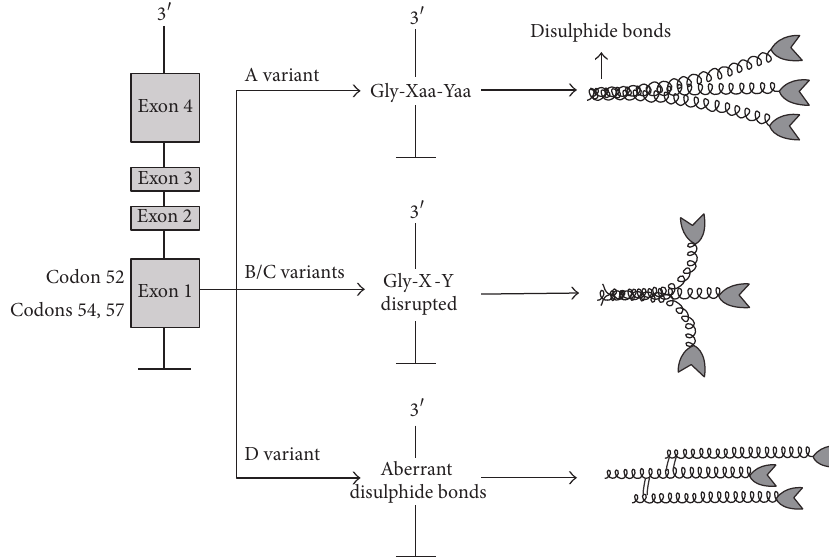
Figure 2: The structural differences due to the variant alleles. Three polymorphisms in the structural gene MBL2, at codons 52, 54, and 57, encode for variant alleles referred to as D, B, and C, respectively; the wild-type gene is A. In the wild type, the correct repetition of Glu- Xaa-Yaa permits the association of three identical polypeptide chains generating the structural subunit. This subunit is stabilized through disulphide bonds in the cross-linking region, with a high-order MBL oligomer formation. The mutations in exon 1 generate three amino acid substitutions in the collagen-like region; two of these substitutions disrupt the Gly-X-Y repeats by exchanging a glycine residue with aspartic acid (variant B) or with glutamine (variant C). A third substitutes a cysteine for an arginine (variant D). These amino acid substitutions disrupt the assembly of the MBL molecule, generating a nonfunctional low-order oligomer formation [15,